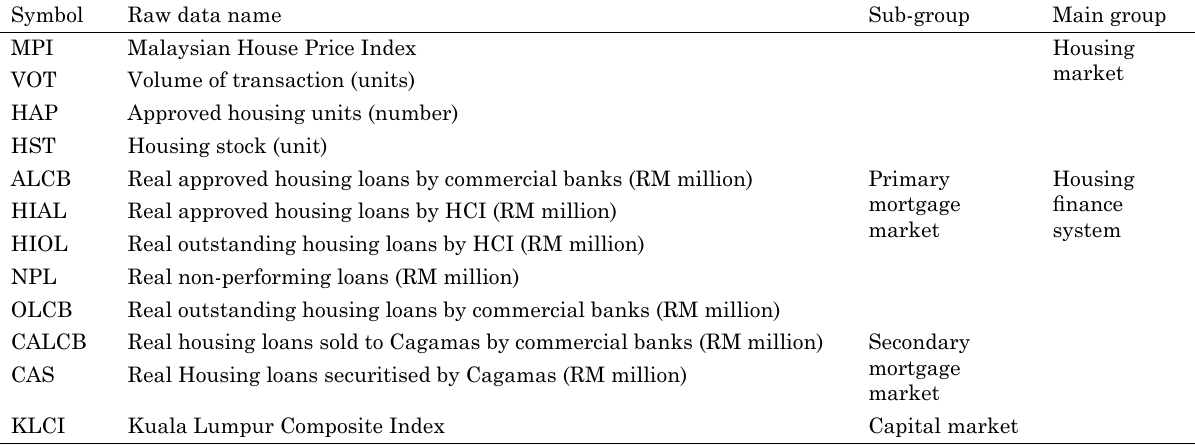
Table 2. List of potential variables for time series modelling